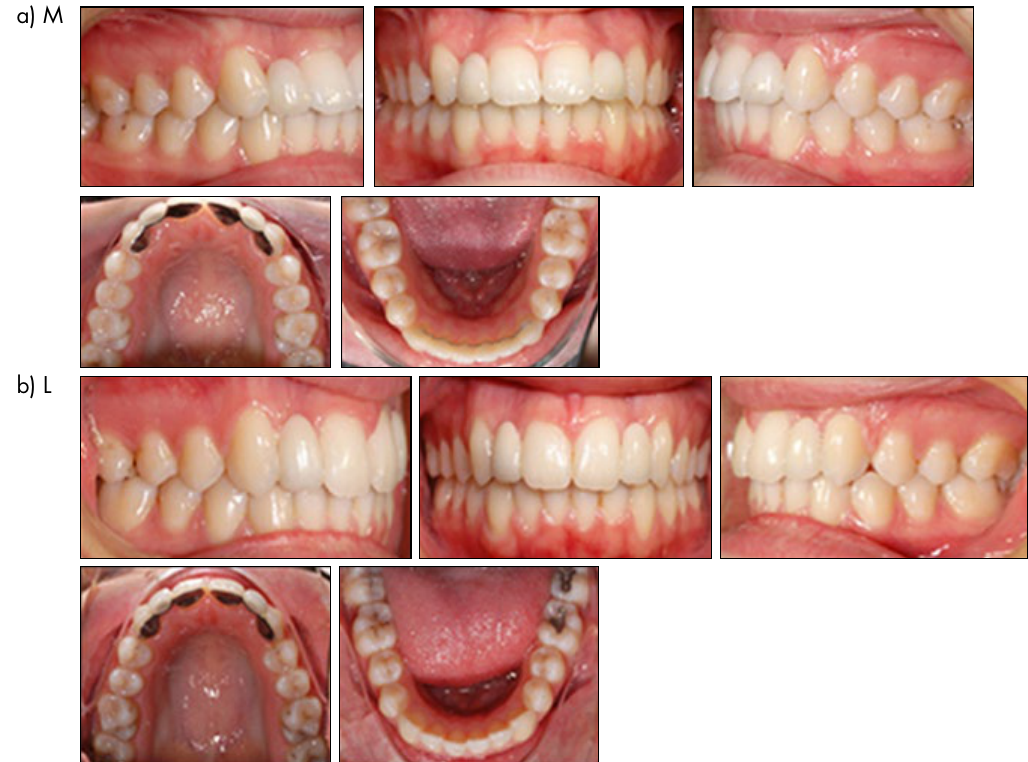
Figure 16. Final photographs after replacement of the maxillary lateral incisors by Maryland bridges at age